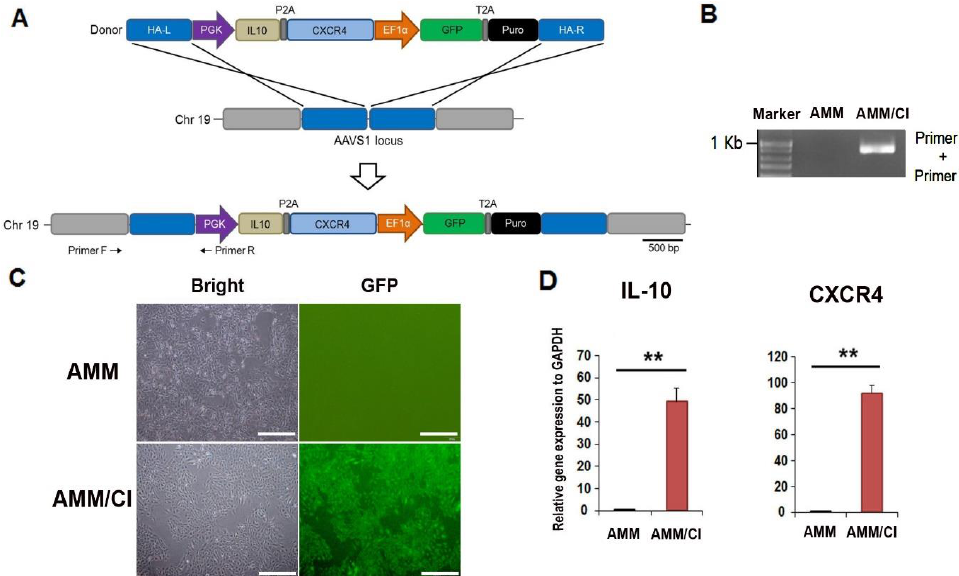
Figure 1. Generation and characteristics of the AMM/CI. ( A ) Schematic picture of the donor plasmid and vector carrying CXCR4 and IL10 targeting the AAVS1 locus. Primers F and R indicate primer lo‑cations for junction detection. Abbreviations: HA‑L, left homology arm; HA‑R, right homol‑ ogy arm; PGK, phosphoglycerate kinase promoter; EF1 α , elongation factor‑1 alpha promoter; Puro, puromycin. ( B ) Result of junction PCR to confirm the correct knock‑in of donor plasmid. ( C ) GFP expression in AMM/CI. Transfected AMM were incubated with puromycin for selection, then iso‑ lated by fluorescence‑activated cell sorting (FACS) selection. Bars = 500 µ m. ( D ) The confir‑mation of CXCR4 and IL10 expression levels in the AMM/CI by qRT‑PCR. ** p < 0.01, n = 4 in each